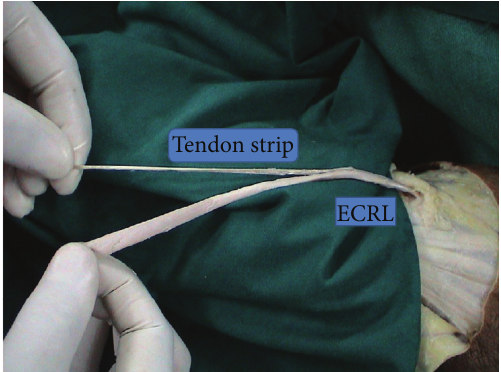
Figure 2: The coiled ECRL tendon and an excised lunatum.